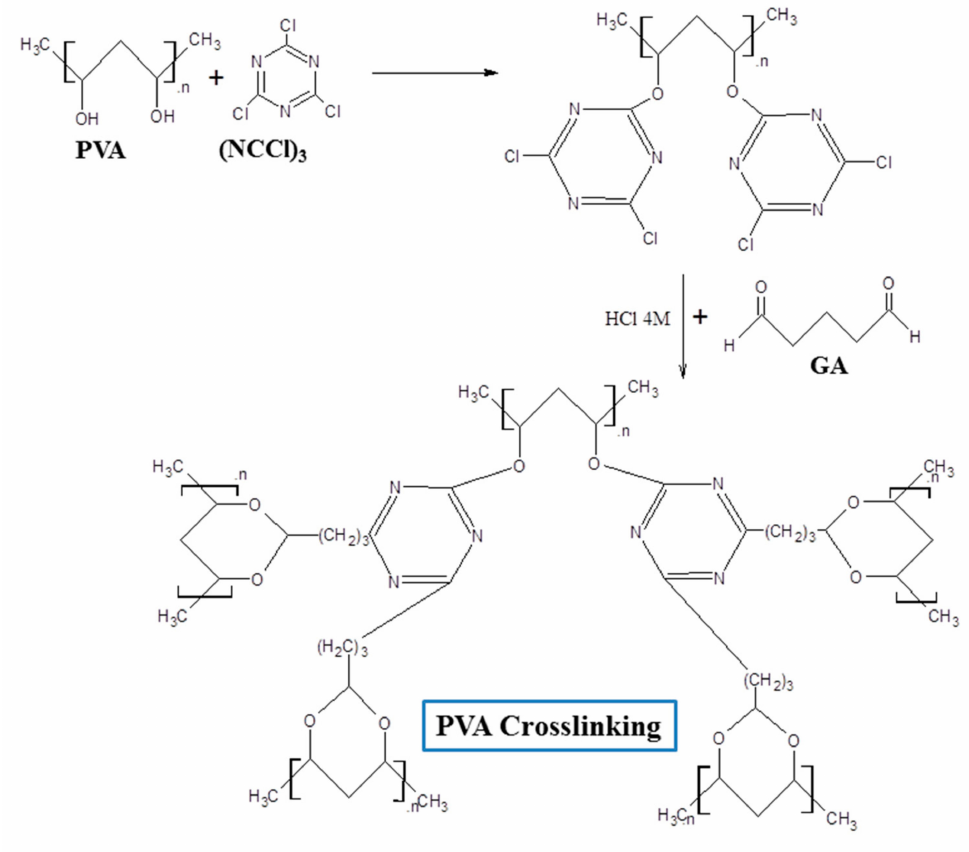
Figure 6. Schematic representation of the PVA membrane formation